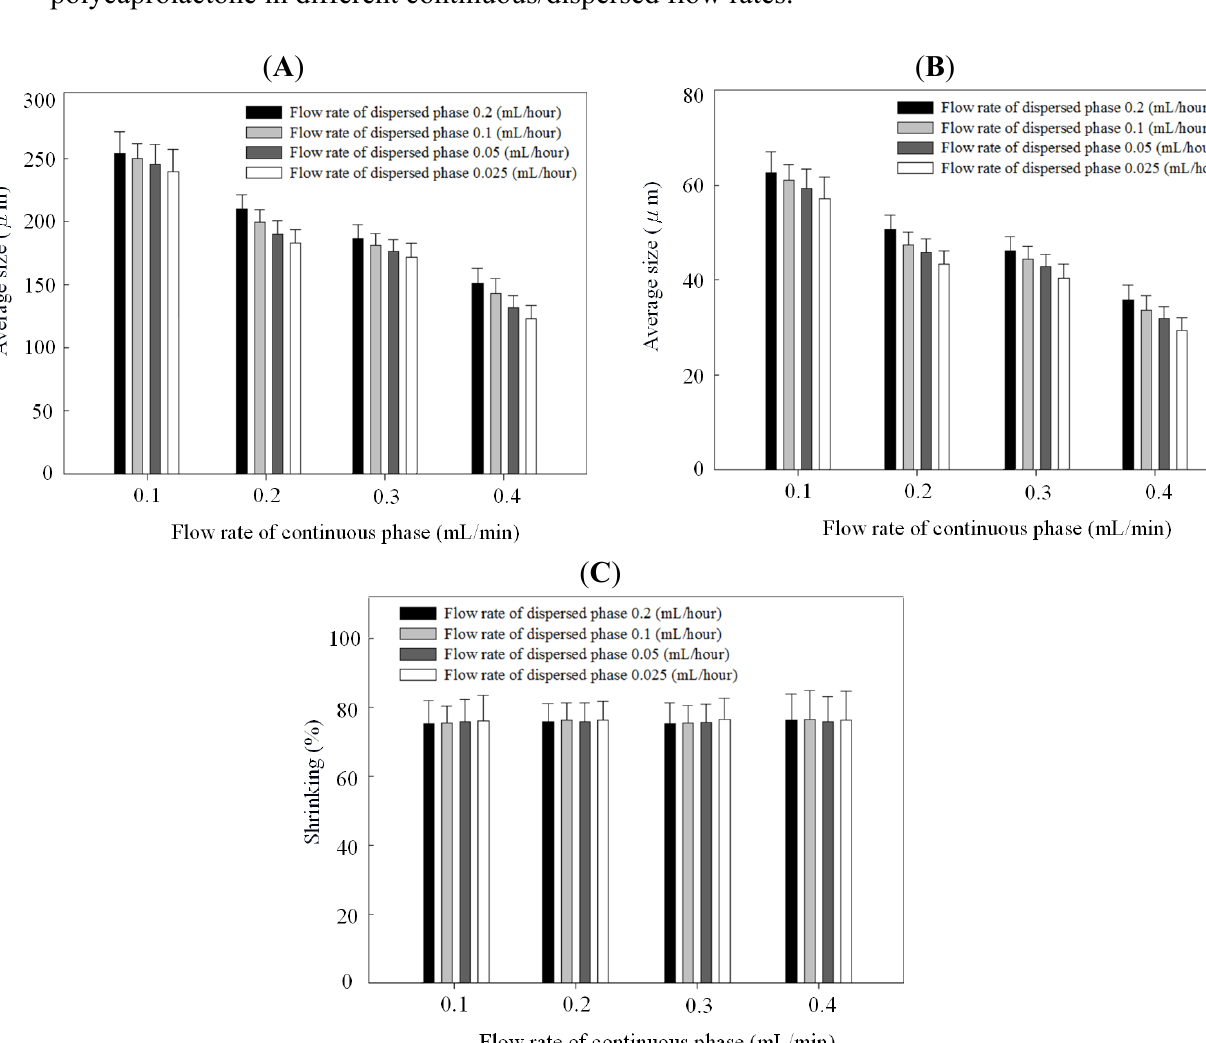
Figure 4. Droplet size ( A ), microparticle size ( B ), and shrinking ratio ( C ) of polycaprolactone in different continuous/dispersed flow